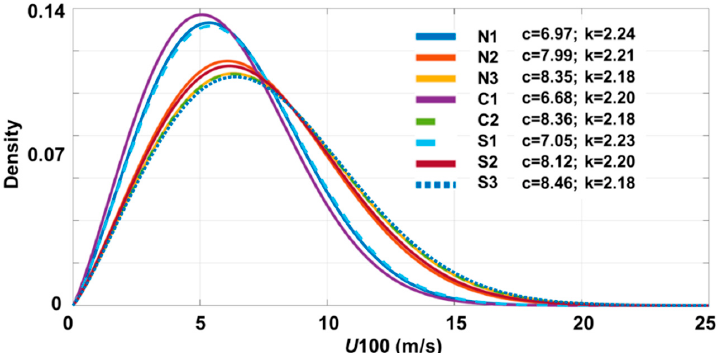
Figure 8. Weibull PDF (probability density function) distributions indicated for all the reference sites, considering the ERA5 wind data for the 20-year time interval of 2000–2019.